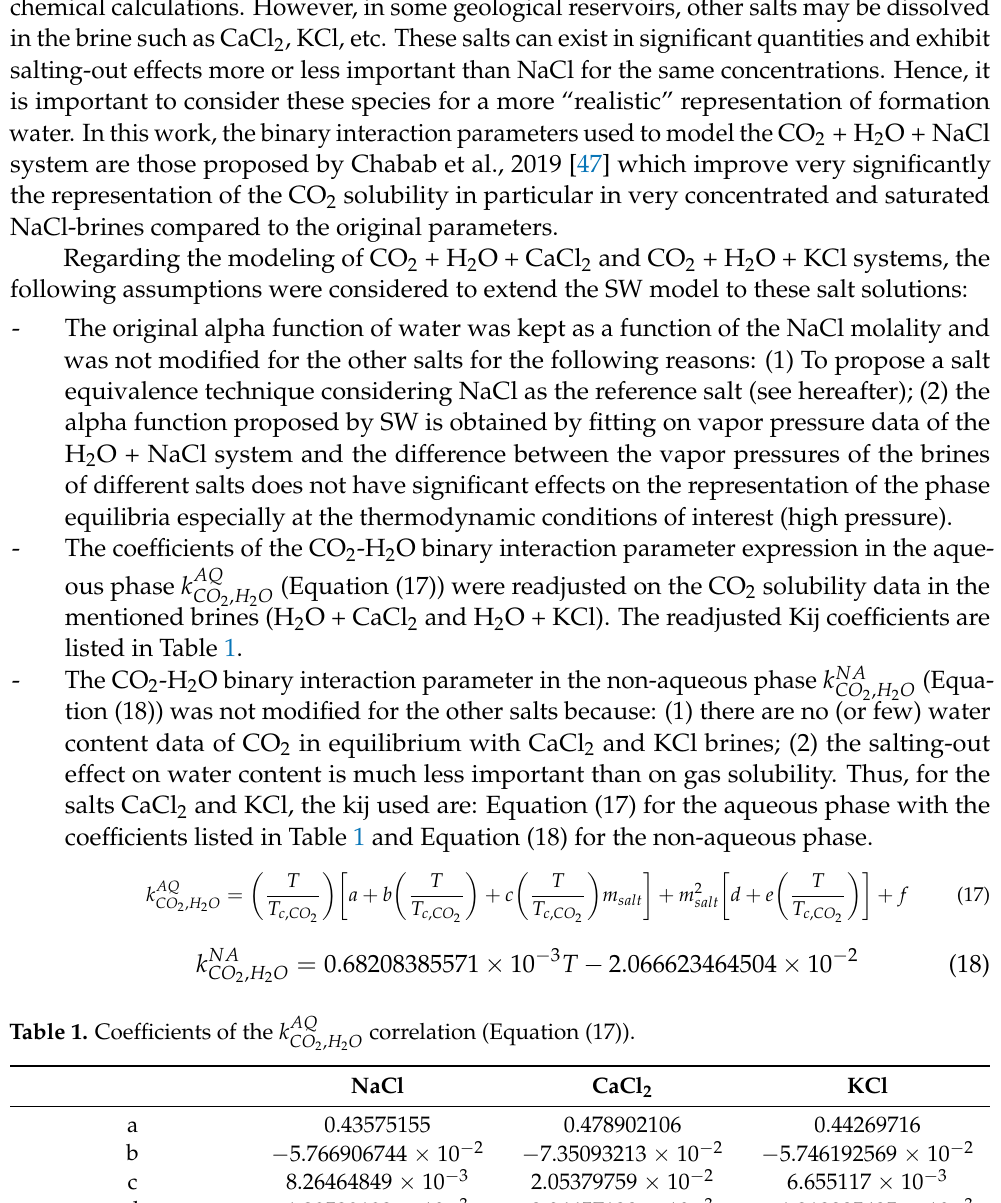
correlation (Equation (17)). CO 2 , H 2 O